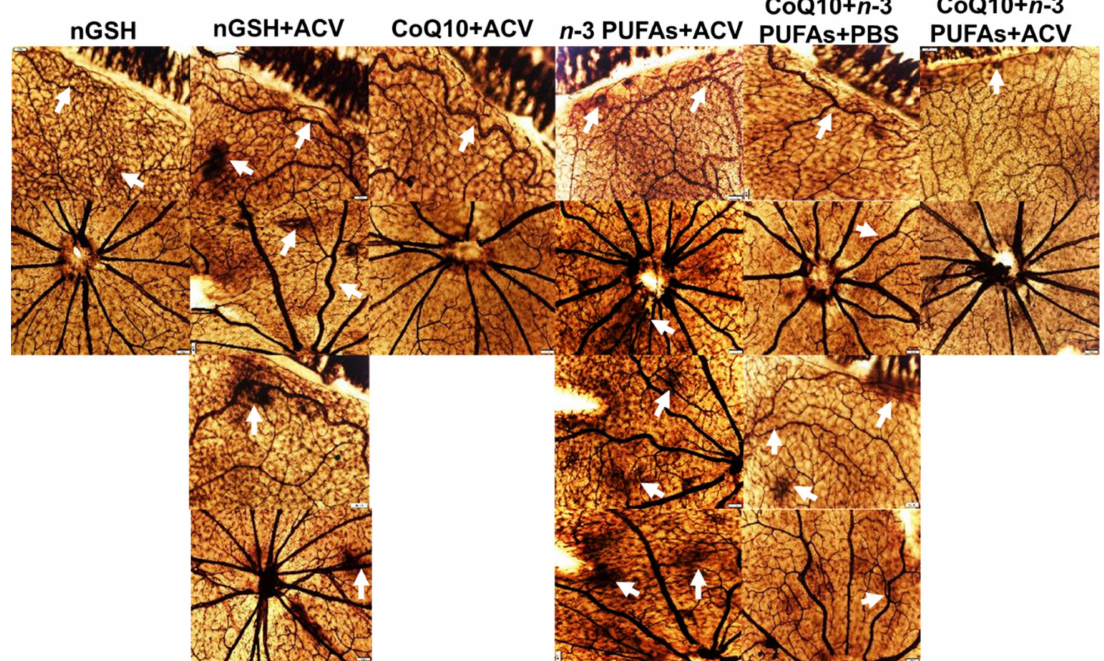
Figure 8. Representative ADPase-stained retinas from rats exposed to neonatal intermittent hypoxia (IH) at postnatal day 21 (P21). The upper panels represent the periphery and the lower panels represent the optic disk. Images are 10 × magnification, scale bar is 100 µ m. Arrow heads show retinal